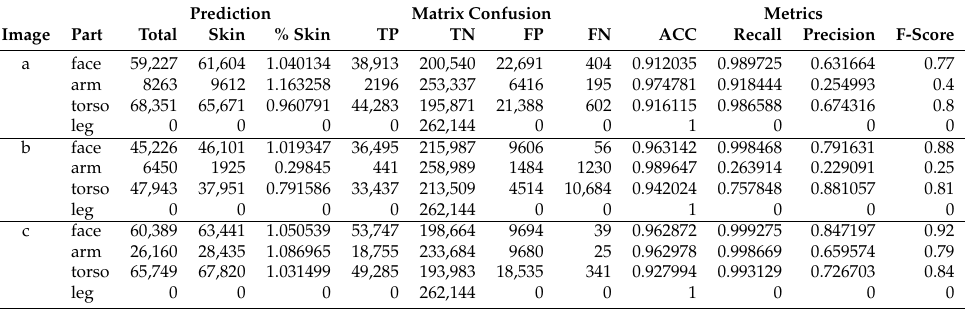
Table 6. Results obtained from the experiment performed on an image containing more than one person, as shown in the input image in Figure 13. Prediction Matrix Confusion Metrics Image